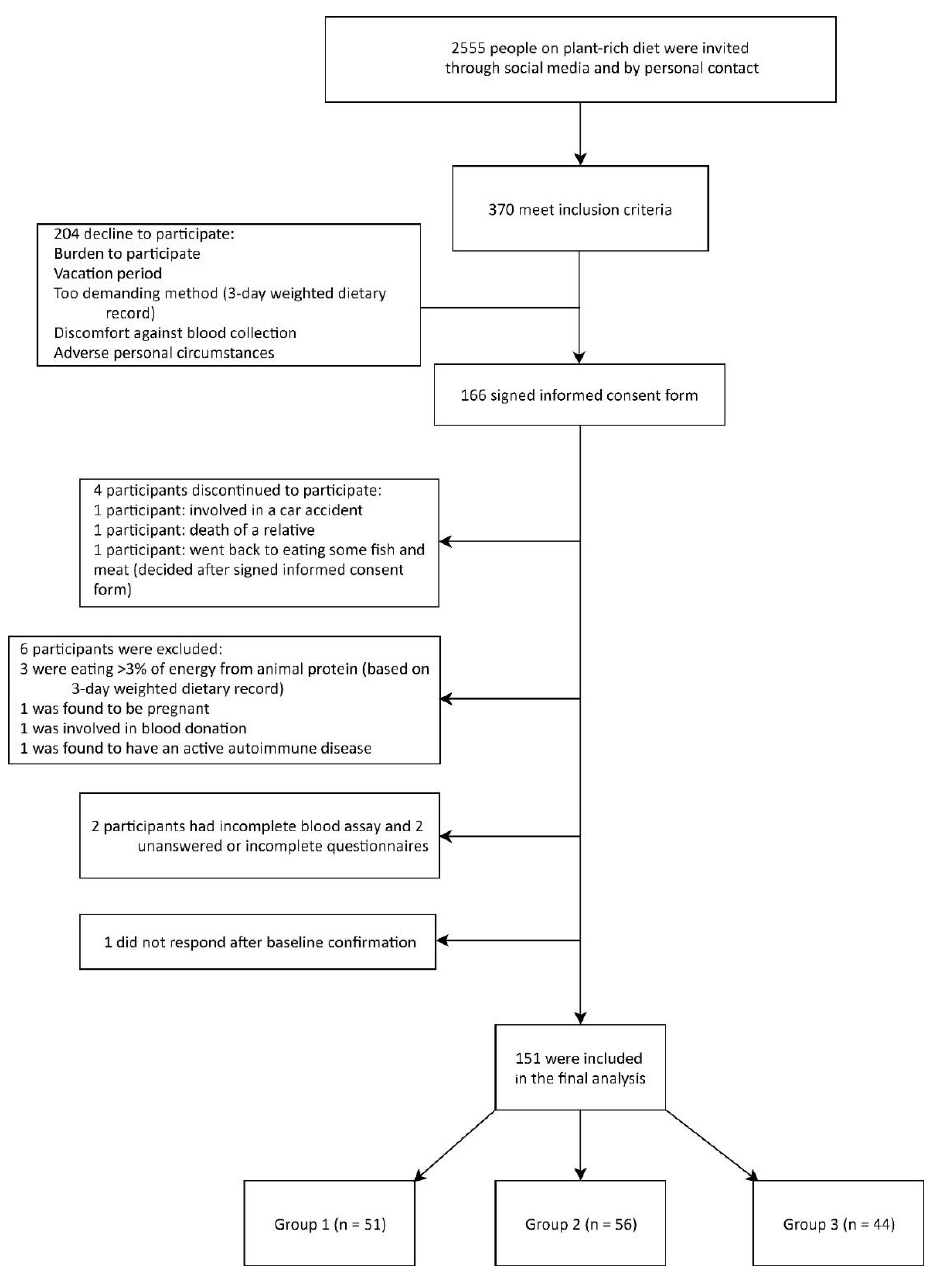
Figure 1. Enrolment of the participants and completion of the study. 3 - DR: 3-day weighted dietary record.